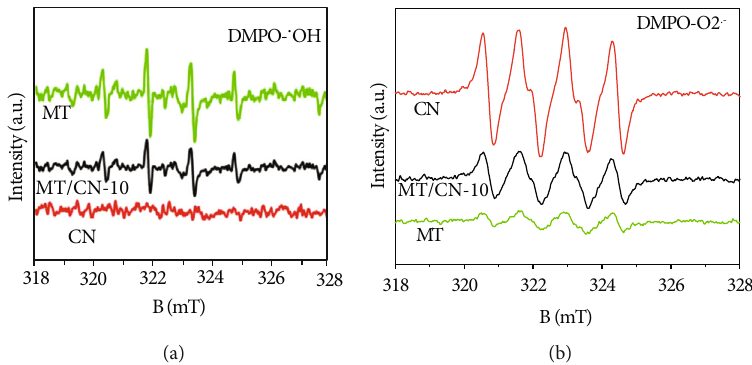
Figure 8: The DMPO spin-trapping ESR spectrum for (a) DMPO- · OH and (b) DMPO- · O 2- under simulated solar light